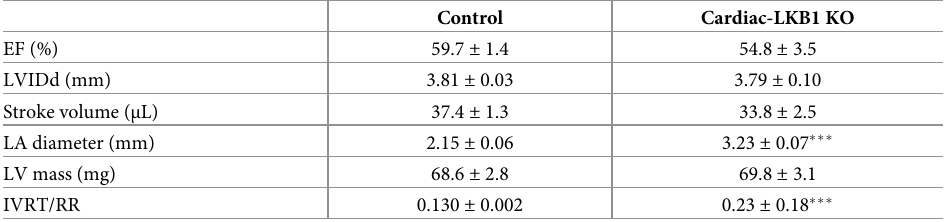
Table 1. Echocardiographic parameters of control and Cardiac-LKB1 KO mice.